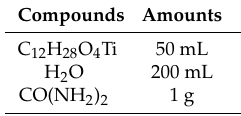
Table 2. Reagents for Synthesis 2.